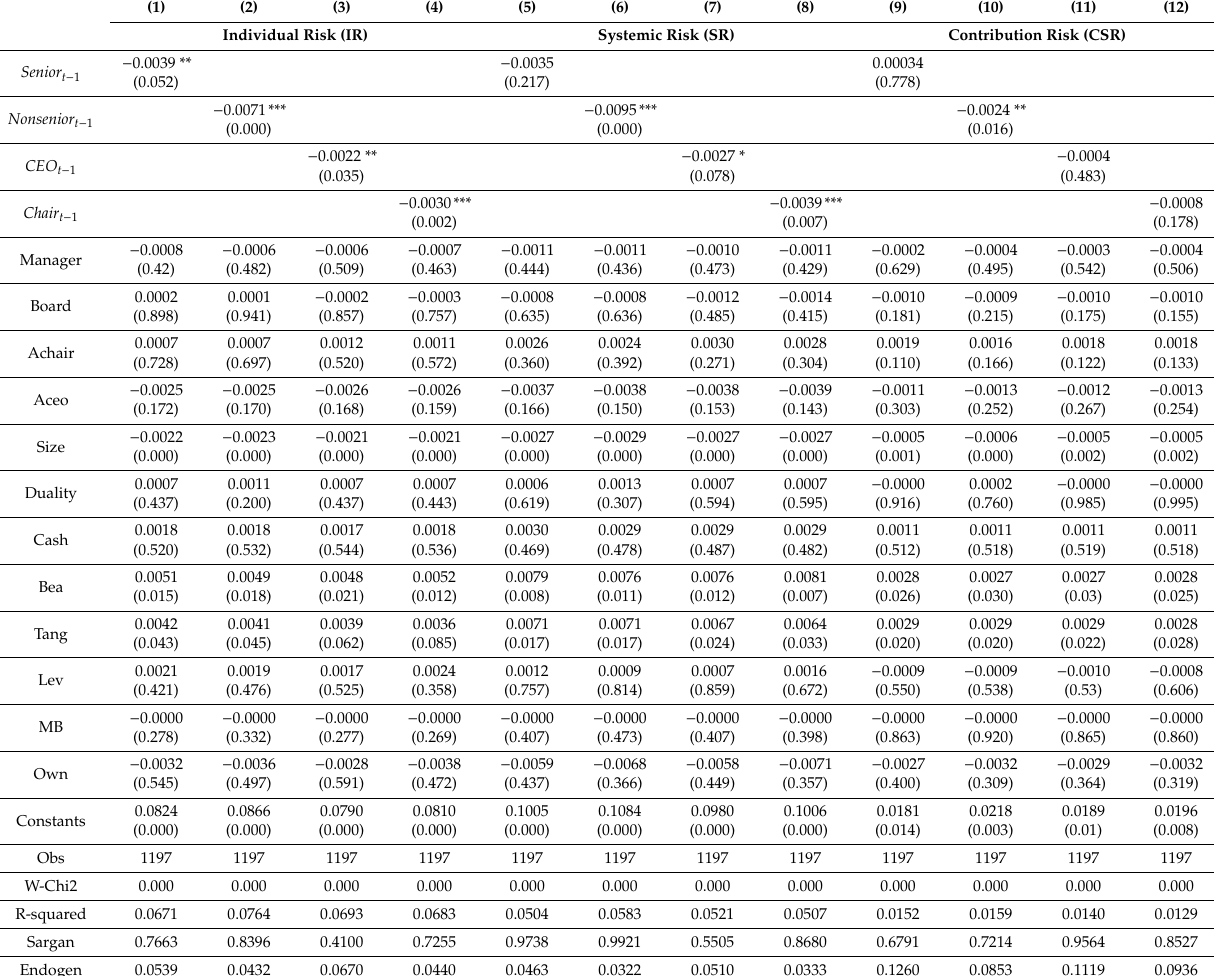
Table 4. Two-stage least squares (2SLS)